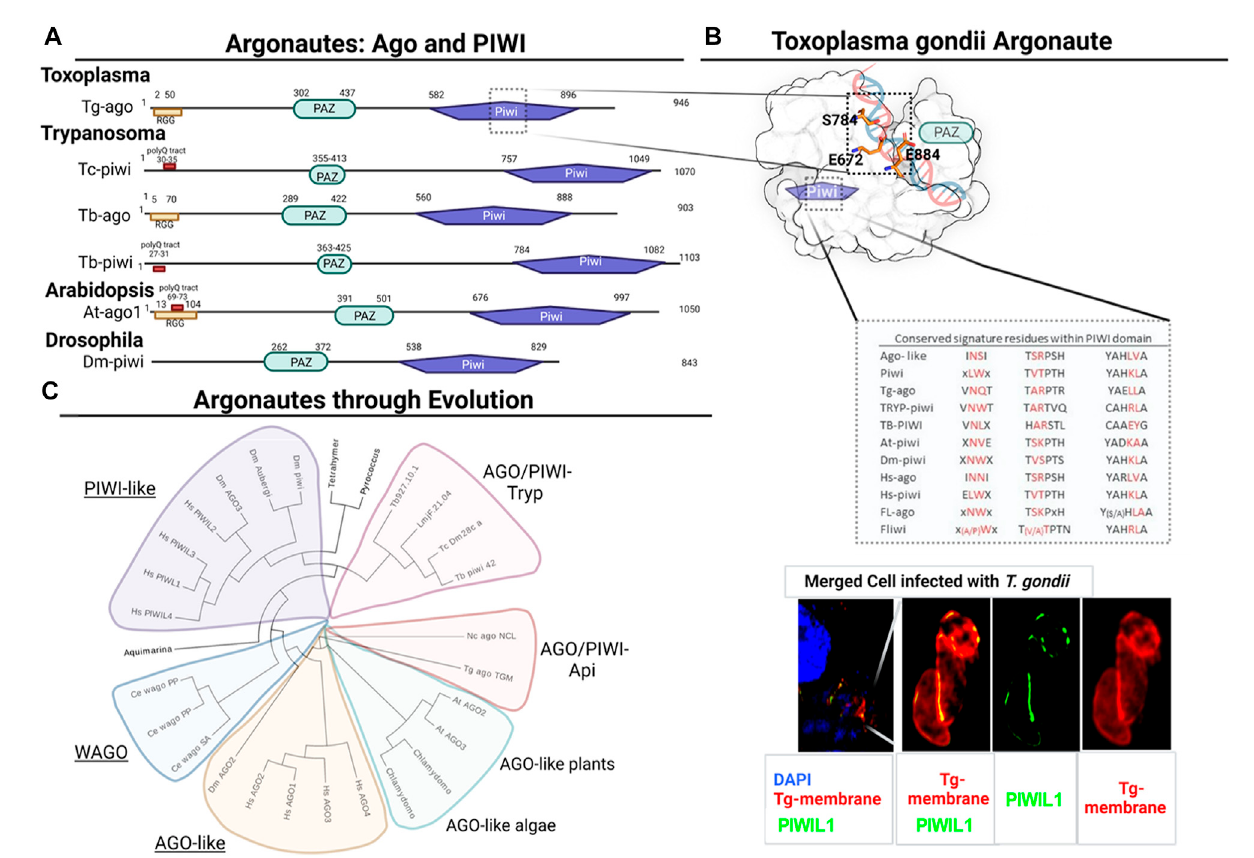
FIGURE 1 Structural domain organization and phylogenetic analysis of Argonaute and PIWI proteins . (A) Domain organization of PIWI proteins from different species.PAZandPIWIareshownincyanandpurpleboxes,respectively.RGGrichzoneandpolyQtractarehighlightedwhenpresent.Tg: Toxoplasmagondii , Tc: Trypanosoma cruzi , Tb: Trypanosoma brucei , At: Arabidopsis thaliana , Dm: Drosophila melanogaster . (B) Surface representation of Tg-Ago Δ -N-terminal structural model. Catalytic triad residues (ESE) are shown as orange sticks. Different motifs within Ago-proteins are compared with group of species, highlighting in red signature conserved residues that de fi ne type/class of Ago/piwi proteins. Immuno fl uorescence assay of Vero cells infected with TgRH Δ ku80 parasites was carried out using the Anti-TcPIWI Antibody (Garcia Silva et al., 2010a) (green), and Anit-SAG1 (red) was used to de fi ne parasites membrane. DAPI labels nuclei. Note that a single Z section is shown for clarity. (C) Phylogenetic relationships among Argonaute and Piwi proteins from the following species: At: Arabidopsis thaliana , Dm: Drosophila melanogaster , HS: Homo sapiens , Ce: Caenorhabditis elegans , Cr: Chlamydomonas reinhardtii , Lm: Leishmania major , Nc: Neospora caninum , Tb; Trypanosoma brucei , Tc: Trypanosoma cruzi , Tt: Tetrahymena thermophila , Tg: Toxoplasma gondii . Unrooted maximum likelihood tree of Argonaute proteins. Proteins among different species and clades were aligned using M-coffee (Wallace,